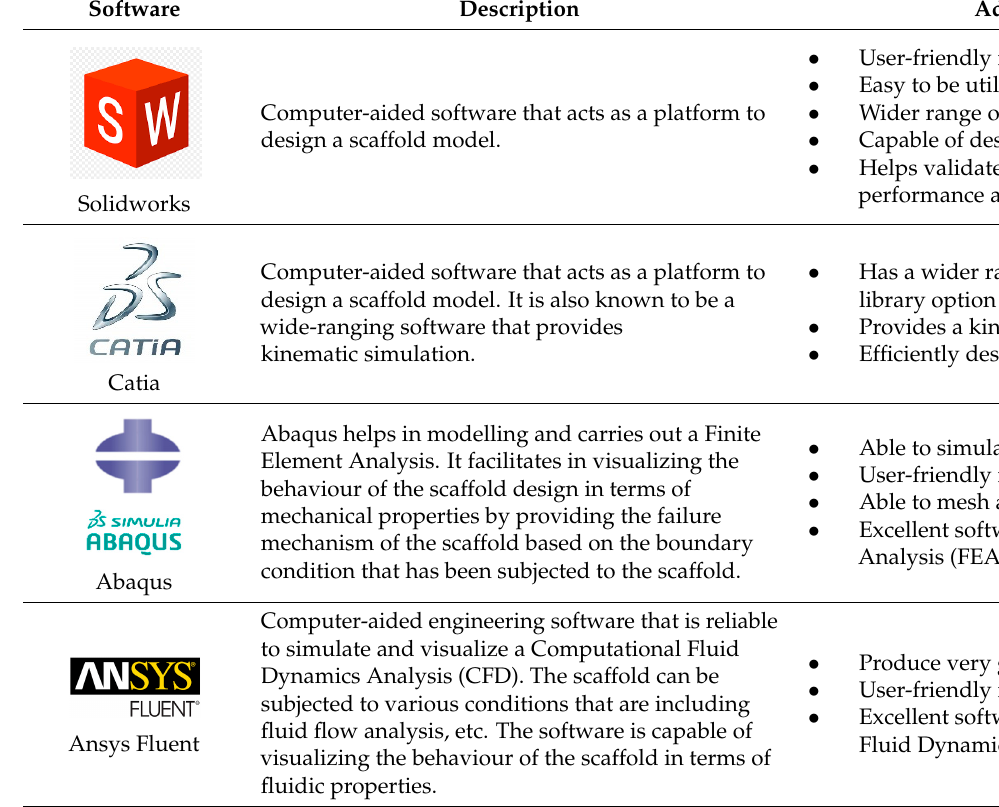
Table 5. Commonly Used Software for Tissue Engineering Scaffold